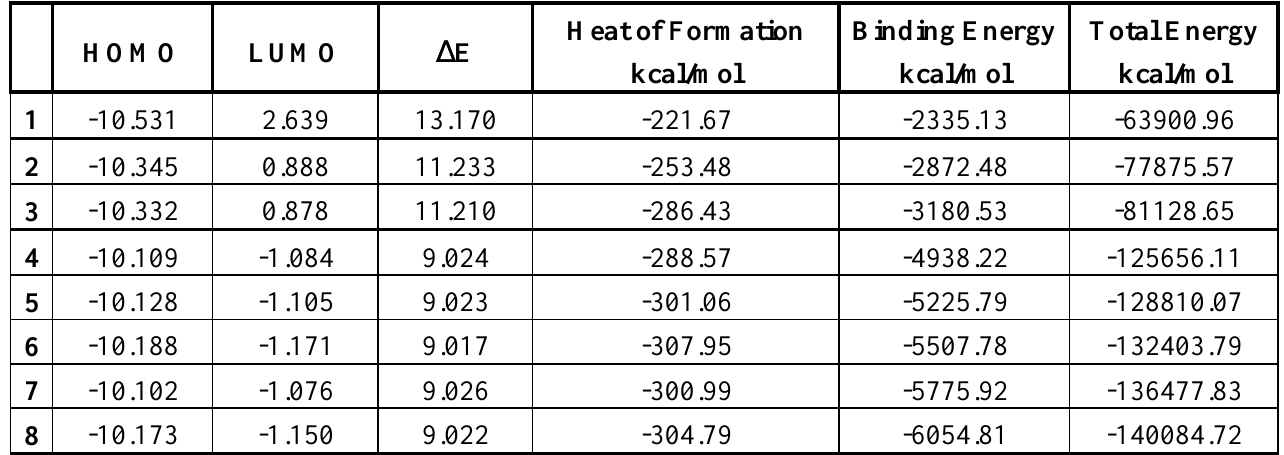
Table 1. HOMO and LUMO Energies, HOMO-LUMO Energy Gaps ( ∆ E) in eV, Heat of Formation, Binding Energy, Total Energy for Compounds